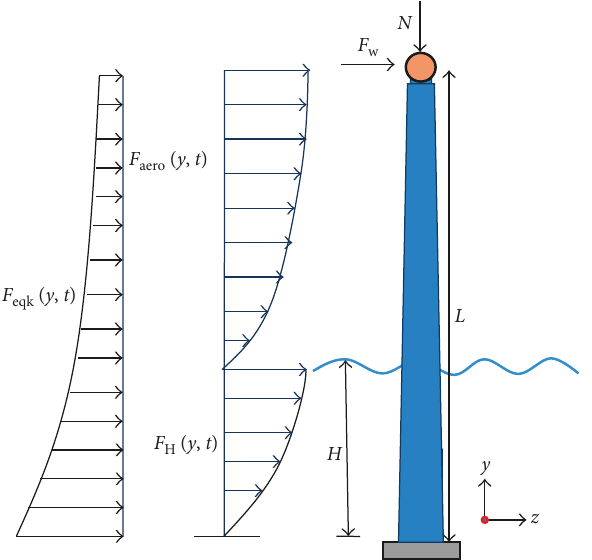
Figure 2: The forces acting on the wind tower.